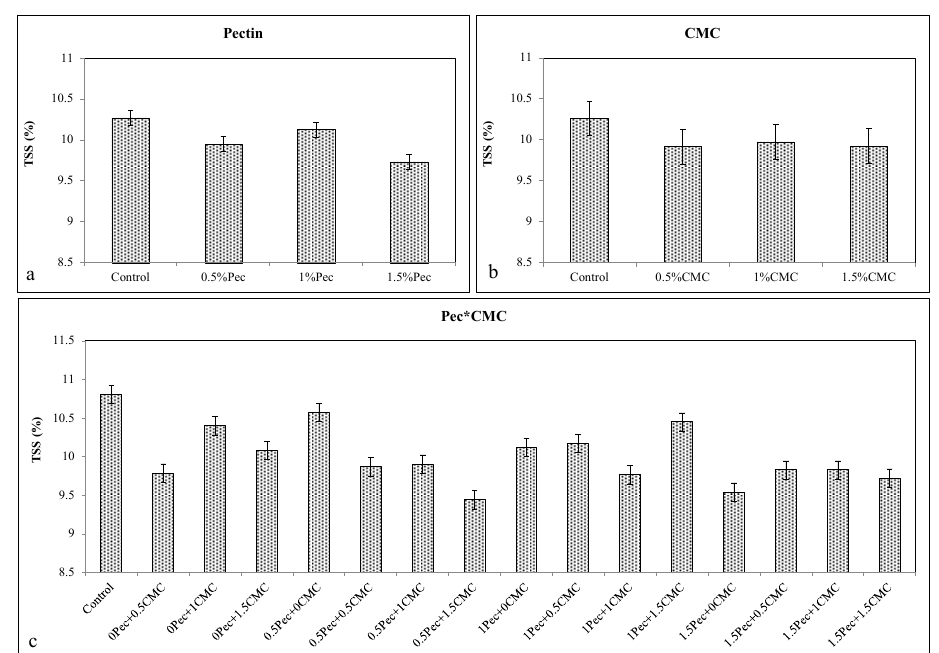
Figure 4. Effect of 0 (control), 0.5 (0.5% Pec), 1 (1% Pec) and 1.5 (1.5% Pec) % pectin-based edible coatings ( a ), 0 (control), 0.5 (0.5% CMC), 1 (1% CMC) and 1.5 (1.5% CMC) % carboxymethylcellulose-based edible coatings ( b ) and their combinations ( c ) on total soluble solids (TSS) contents during cold storage period. Data are the “estimated marginal means ±95% confidence intervals”. The results were expressed on a fresh weight basis. The columns with non-overlapping error bars are significantly different ( p ≤ 0.05).